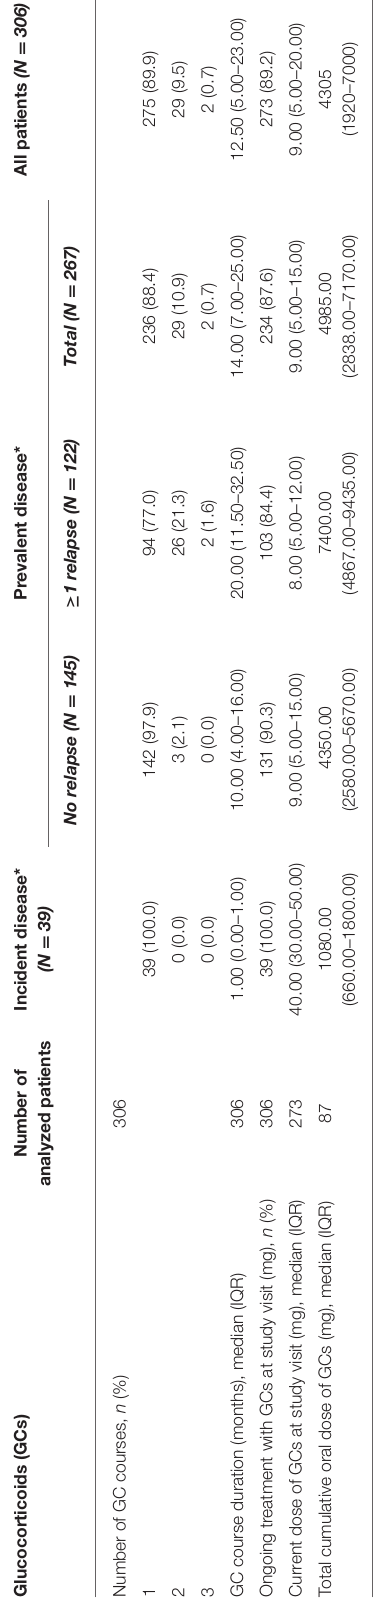
TABLE 4 | Adjunctive treatments for giant cell arteritis since